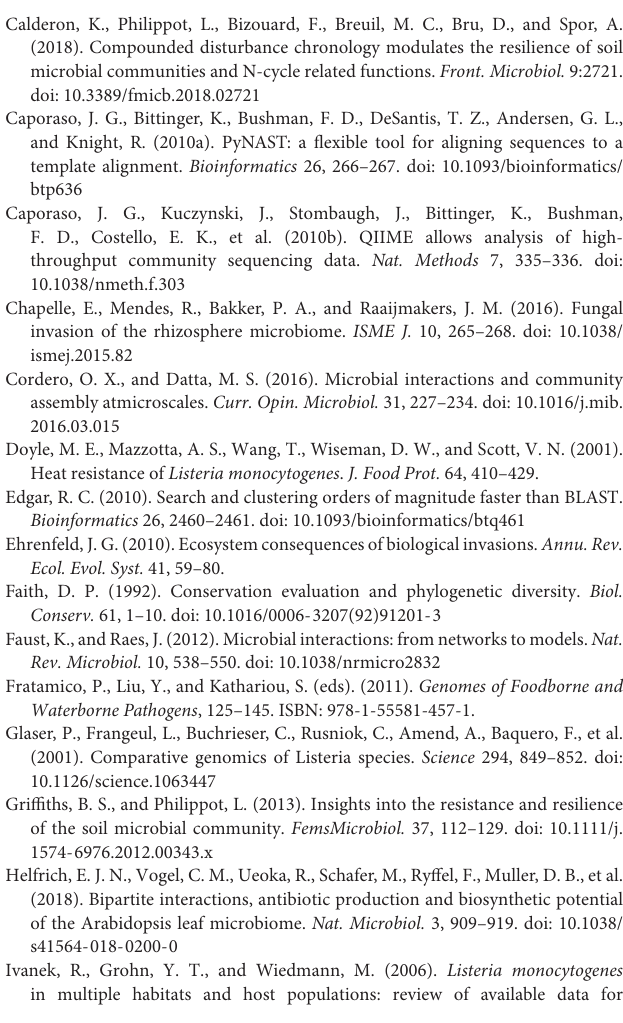
according to Tukey’s test ( P < 0.05). Average and standard error of the mean are displayed. FIGURE S4 | OTUs displaying significantly higher abundance in the treatment HeatT0/HeatT20 than in the treatment ColdT0/ColdT20 applied to soil E microcosms. After 16SrDNA diversity analysis, abundance of detected OTUs was compared between treatments. Rarefaction of all samples was set at 3500 sequences. The frequency of each OTU was determined after dividing the number of reads by 3500. Significance of OTUs with higher abundance was assessed according to Tukey’s test ( P < 0.05). Average and standard error of the mean are displayed. FIGURE S5 | Assessing the effect of L. monocytogenes inoculation on the initial bacterial diversity in soil E and soil D at T0. (A) Species richness estimated by the observed species index. (B) Evenness estimated by Simpson’s reciprocal index. (C) Phylogenetic diversity estimated by Faith’s phylogenetic diversity index. Results for inoculated and non-inoculated microcosms are shown in black and gray respectively. TABLE S1 | Summary of the significance of the differences of populations of L. monocytogenes between treatments and control during incubation in soil E